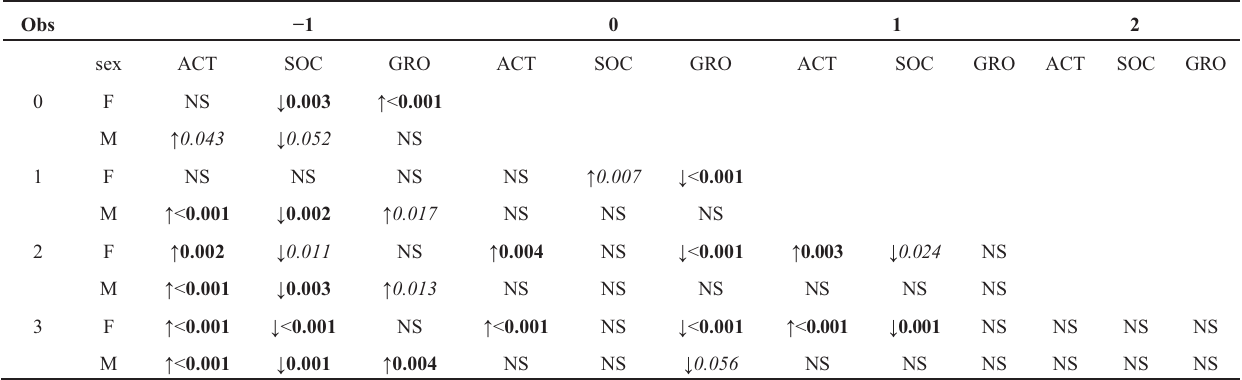
Table 3. Behavioral observations; Comparison between observations, (cid:3)1: 1 week before transfer; 0: directly after transfer; 1: 1 week after transfer; 2: 2 weeks after transfer; 3: 3 weeks after transfer (significant: bold p -value, trend: italic p -value), Split for sex. (cid:5): increase or (cid:6): decrease of behavior during obseravtion on vertical axis ( left ) compared to behavior during observation on horizontal axis ( top ) n = eight